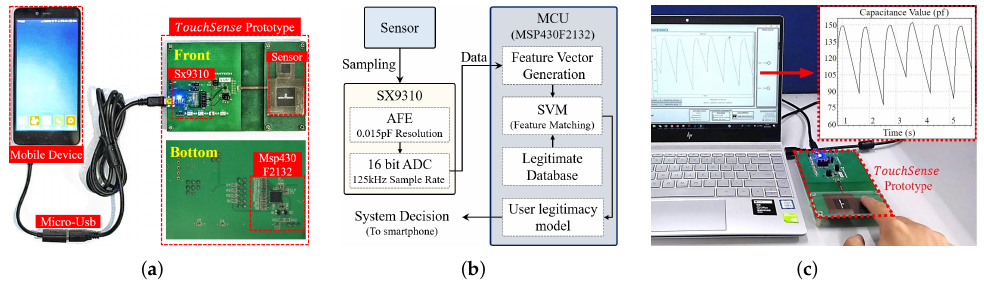
Figure 7. BioTouch contains a novel designed PCB to control the device. We can also use a laptop to monitor the working states of the prototype, where the sensed capacitance value is shown in the window in real time. ( a ) BioTouch prototype. ( b ) Prototype block digram. ( c ) Working status monitoring of